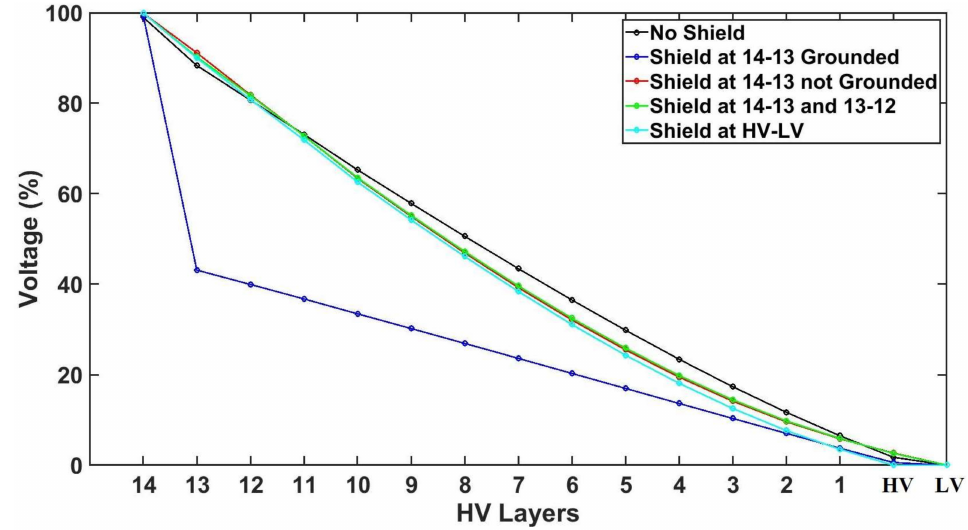
Figure 26. The e ff ect of shield on initial voltage distribution for